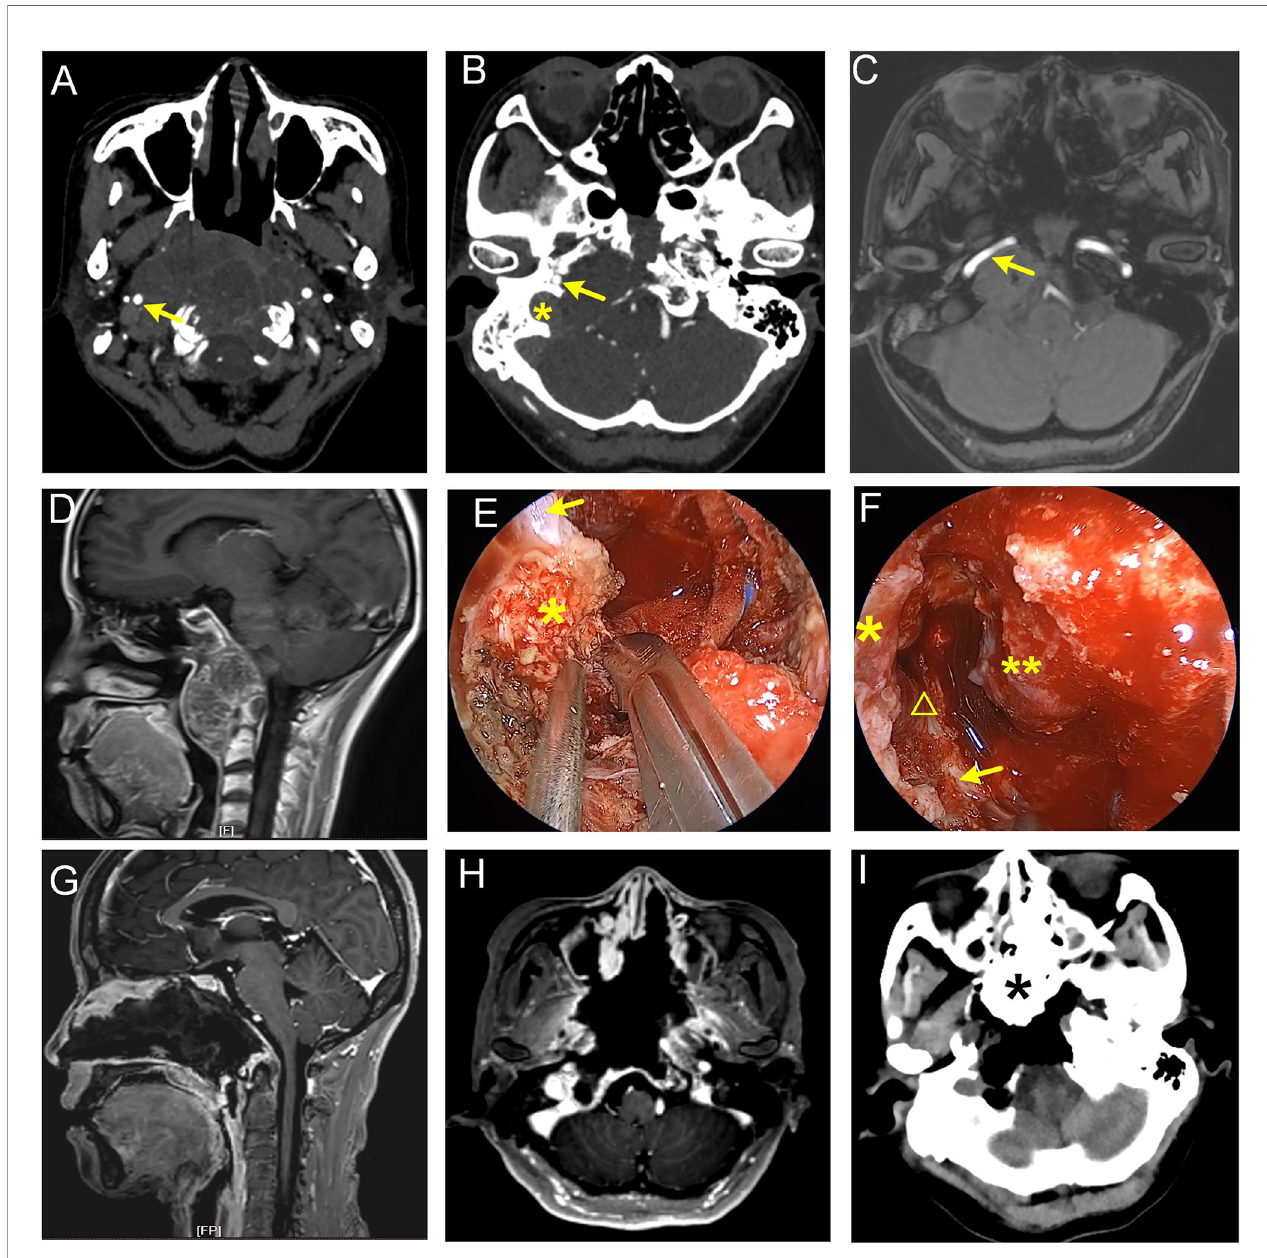
FIGURE 4 | Giant recurrent chordoma involving petroclival fi ssure, jugular foramen, and craniocervical junction. (A – D) Preoperative images show that the tumor grew along the right petroclival fi ssure and destroyed petrous and clival bone. Parapharyngeal, petrous, lacerum, and paraclival ICA were involved. The arrow in (A) represents parapharyngeal ICA. Arrows in (B, C) represent petrous ICA, and the asterisk in (B) represents jugular foramen. (E, F) Intraoperative view. (E) Cut the hard scar and fi brocartilage following the course of the ICA with a sharp knife. The arrow denotes paraclival ICA. The asterisk indicates fi brocartilage tissue at lacerum. (F) Lacerum, petrous, and parapharyngeal ICA were exposed. Asterisk represents lacerum ICA, the triangle represents petrous ICA, the arrow represents parapharyngeal ICA, and the double-asterisk represents clival dura matter. (G – I) Postoperative images show that the tumor was near-totally removed. The asterisk in the panel I represents iodoform